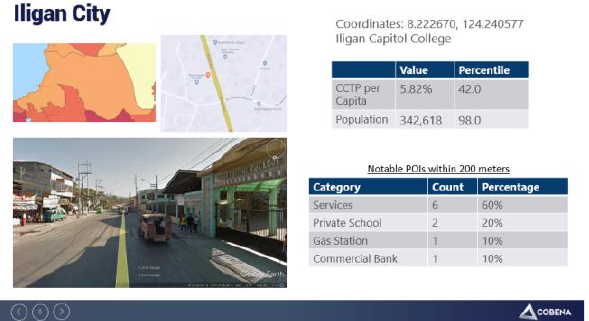
Figure 16. Potential site for a new bank branch in Iligan